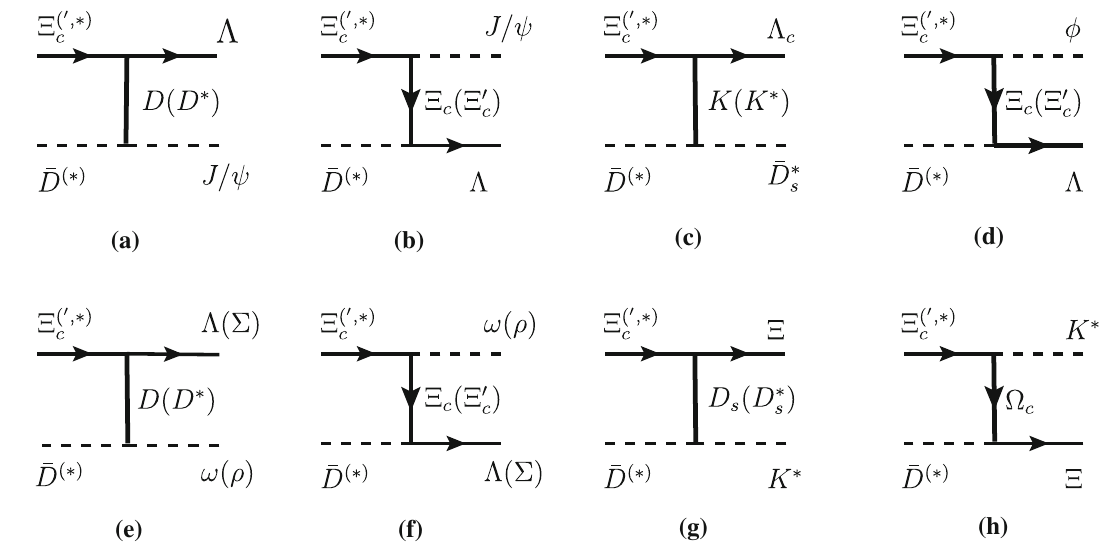
Fig. 1 Two-body strong decay diagrams for the P cs ( 4459 ) as a coupled (cid:2) c ¯ D ∗ /(cid:2) ∗ c ¯ D /(cid:2) (cid:3) c ¯ D ∗ /(cid:2) ∗ c ¯ D ∗ molecule with I ( J P ) = 0 ( 3 / 2 − ) in the hadron